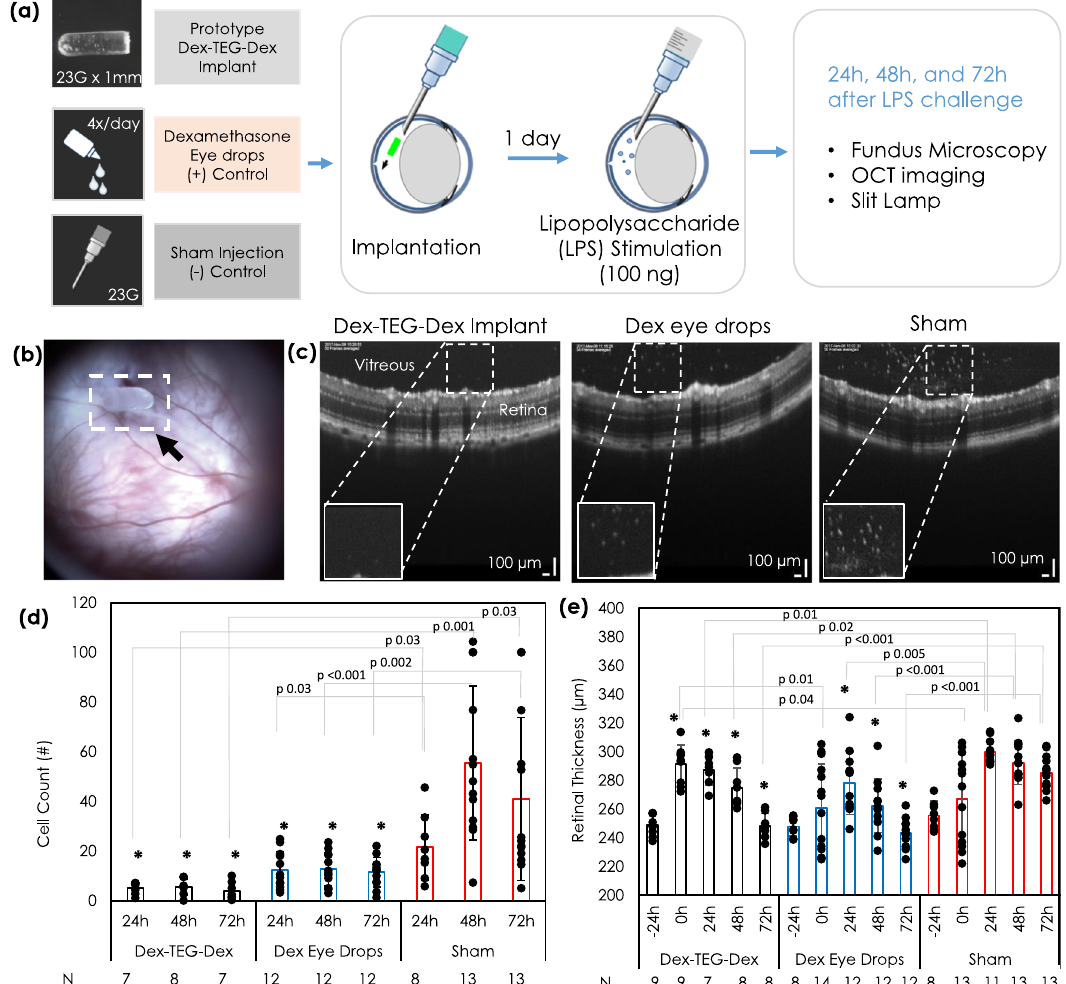
(Fig. 8c, d). Little to no drug was measured in the aqueous humor (Fig. 8e), an off-target tissue where the presence of corticosteroids could induce corticosteroid-associated adverse effects 50 . In con- trast, Ozurdex ® , a PLGA-based implant that is the market leader in corticosteroid-based intravitreal drug delivery (60:40 Dex: polymer ratio) 1,51 , experienced a burst release, with peak drug levels two orders of magnitude higher than the dimer implant at 1 month post injection and rapidly dissipated below detection limits shortly thereafter. Furthermore, elevated drug levels were found in the anterior chamber for Ozurdex ® , an off-target site, while levels of dexamethasone in the aqueous humor for Dex- TEG-Dex were below the limit of quanti fi cation for most samples 52,53 . A well-documented side effect of intraocular use of corticosteroids, including dexamethasone, is an increase in intraocular pressure 54 . This is also reported clinically with Ozurdex ® 18 . This increase in intraocular pressure is primarily caused by an increased resistance to the out fl ow of aqueous humor. While the precise mechanism causing